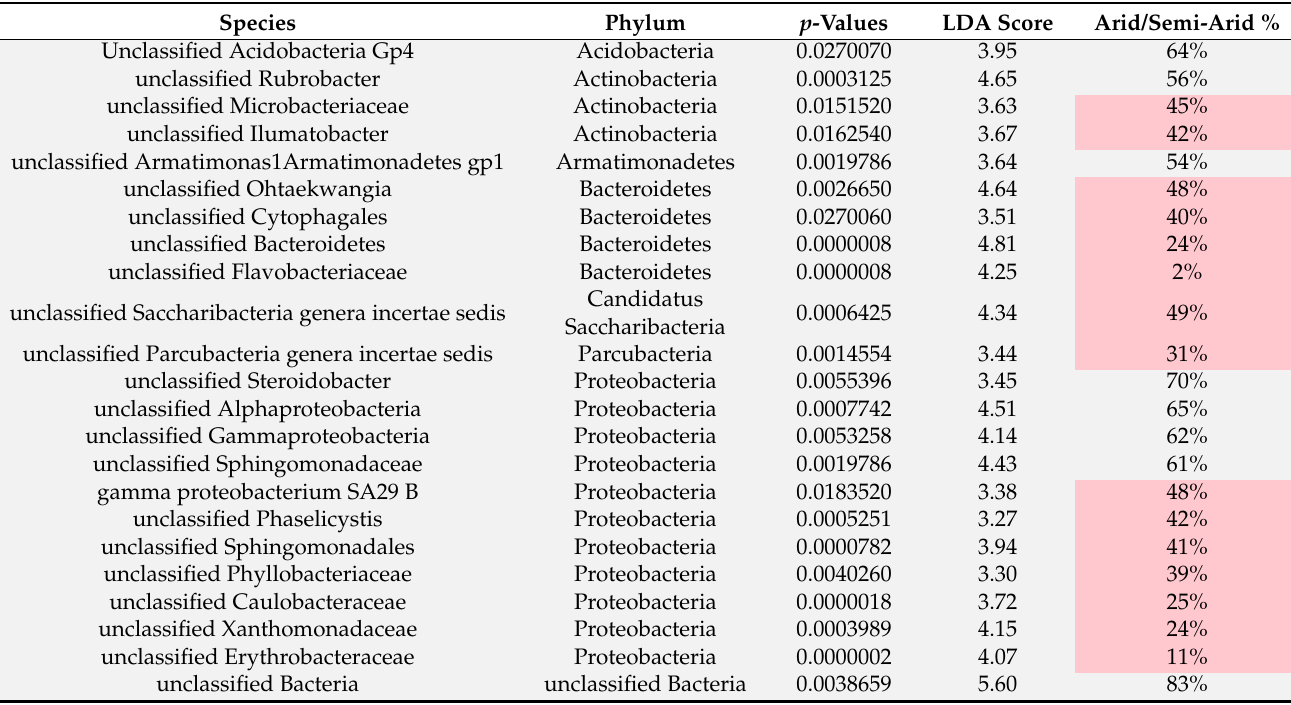
Table 1. Signature. LEfSe (Linear discriminant analysis Effect Size) at species level according to climatic zone. Light gray indicates species less present in the arid zone than in the semi-arid one and red indicates a presence less than 50%. Dark gray indicates species more present in arid zone than in the semi-arid one and green indicates a presence more than 200%. LEfSe results using non-parametric factorial Kruskal-Wallis (KW) sum-rank test. Adjusted p -value cutoff = 0.05 and LDA score = 1.0. LEfSe analysis was performed with